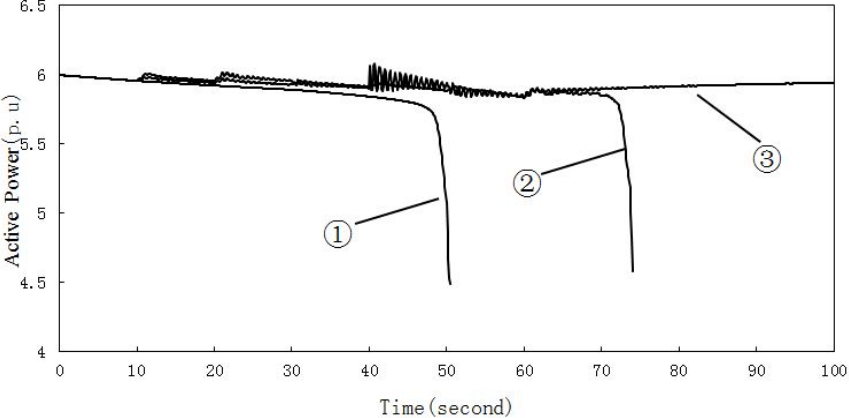
Figure 7. Active power curve of generator 2.